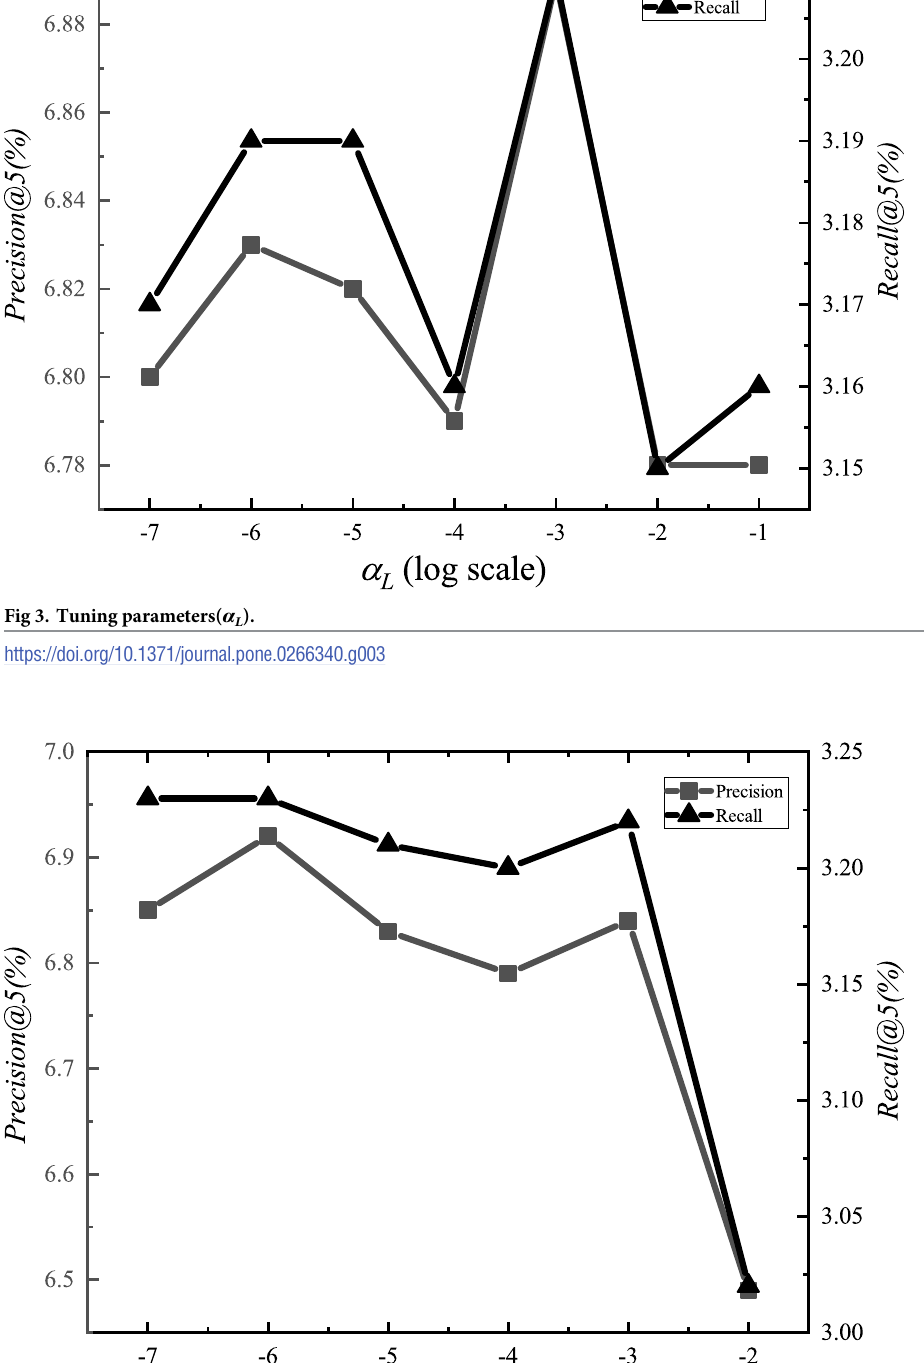
Fig 4. Tuning parameters( α